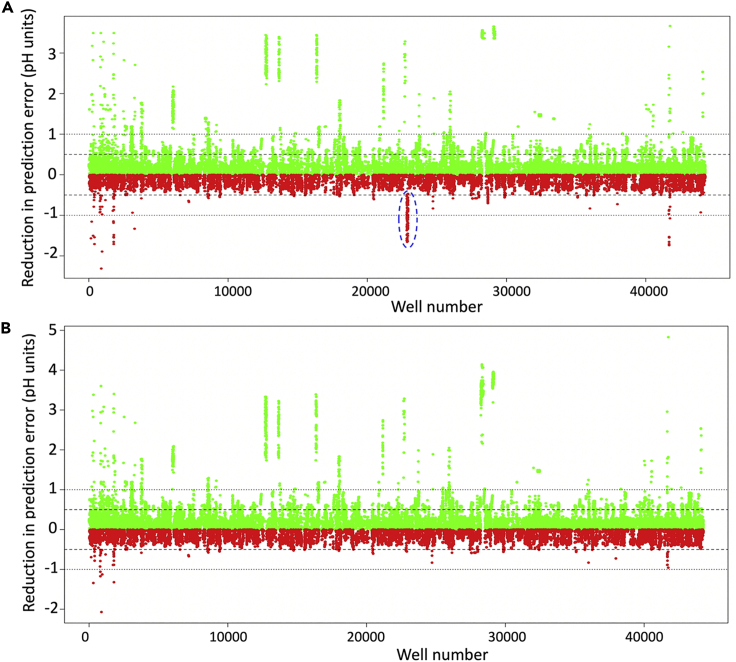
The Reduction in Error Obtained by Modeling the Effect of Additive Chemicals on the Buffer pH when Compared with Using the Buffer pHGreen points indicate wells for which the predicted values have less error (from the measured pH) than the buffer pH, and red points indicate those for which the error is actually made worse. Although many errors are improved, in several cases by more than 2 pH units, most increases in error are by less than half a pH unit. Some of the worst error increases are from consecutive wells, highlighted by the blue dashed ellipse in (A). After modeling the combination of sodium dihydrogen phosphate and potassium hydrogen phosphate separately, these large errors no longer occur (B).